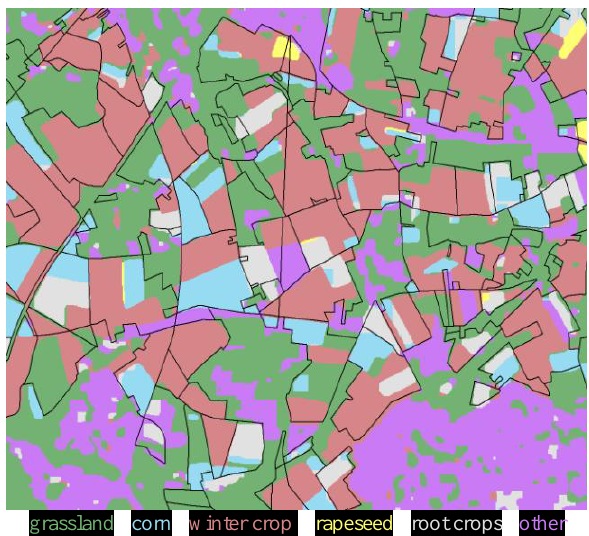
Figure 4. CRF multi -classification superimposed by GIS cropland object borders (black